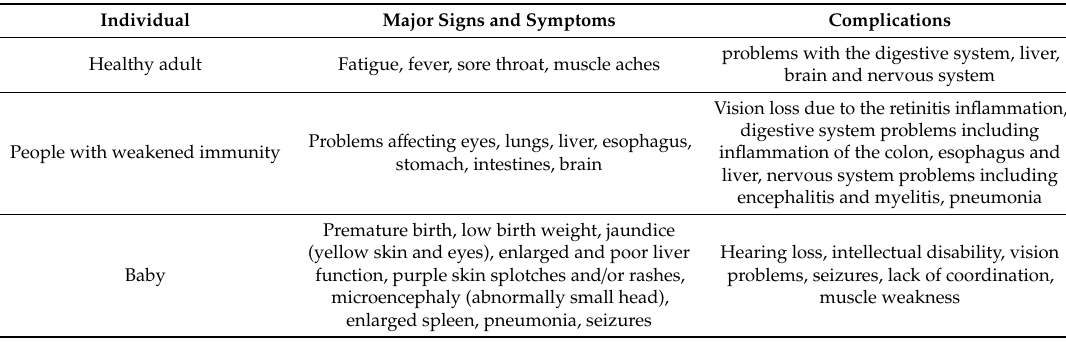
Table 1. CMV influence on